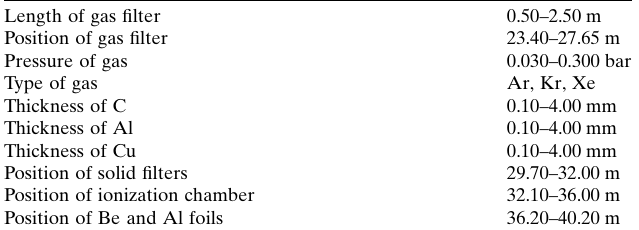
Table 2 Parameters needed to be optimized and their ranges.